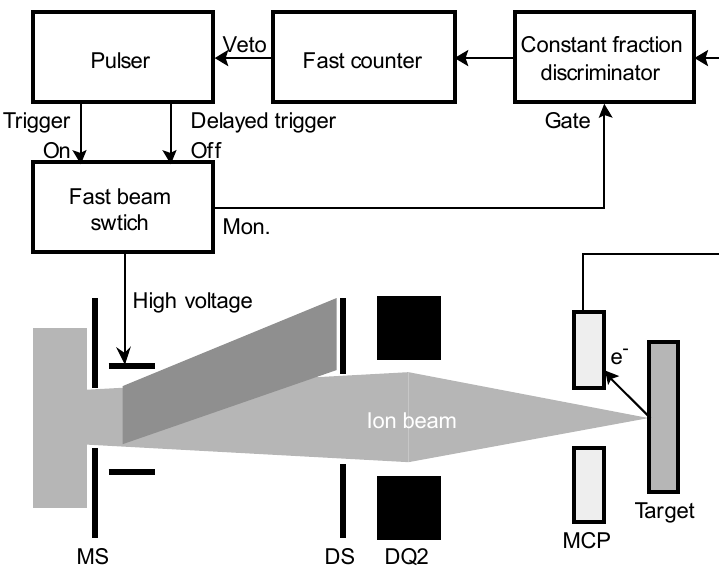
Figure 16. A schematic diagram of the single ion hit system.